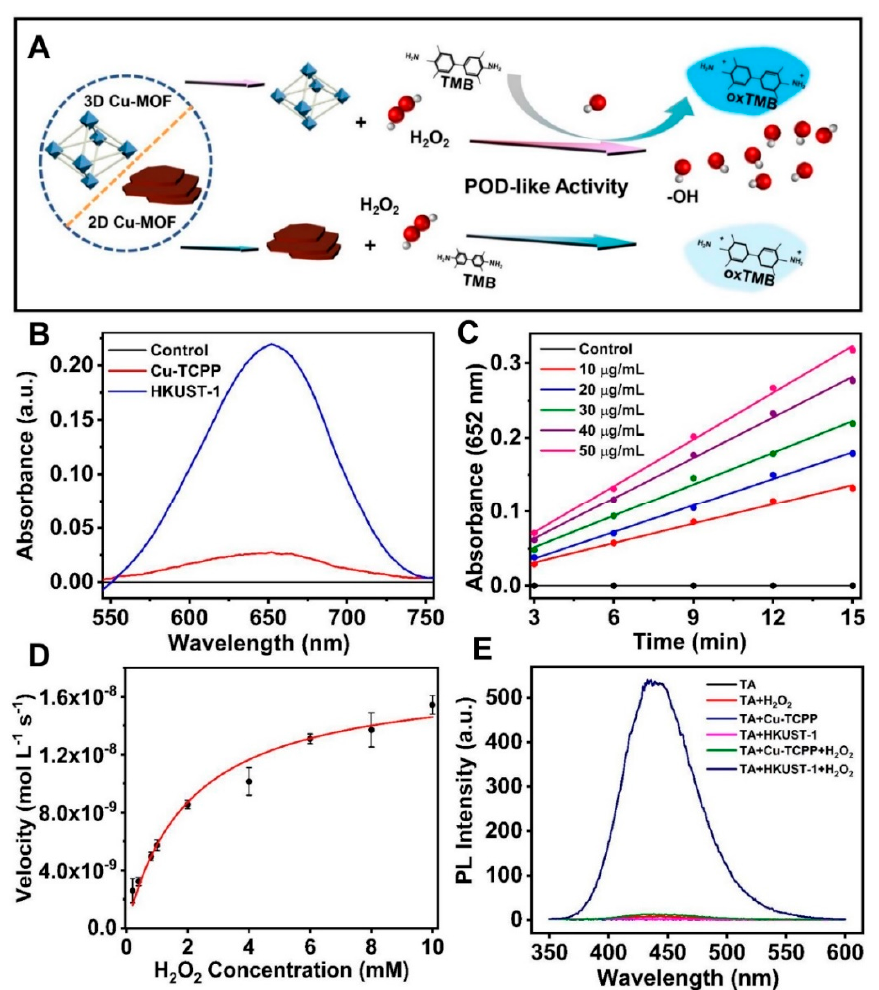
Figure 2. ( A ) Schematic diagram of the mechanism for POD-like activity in two different dimensions of MOF. ( B ) The UV–vis absorbance spectra of TMB in different reaction systems: H 2 O 2 + TMB, Cu-TCPP+ H 2 O 2 + TMB, and HKUST-1+ H 2 O 2 + TMB. ( C ) Kinetic curves of prepared Cu-MOFs artificial enzyme with varied concentrations. ( D ) Steady-state kinetic assays of HKUST-1 for H 2 O 2 . ( E ) Fluorescence spectra of different reaction systems: TA, TA + H 2 O 2 , TA + Cu-TCPP, TA + HKUST-1, TA + H 2 O 2 + Cu-TCPP and TA + H 2 O 2 + HKUST-1.